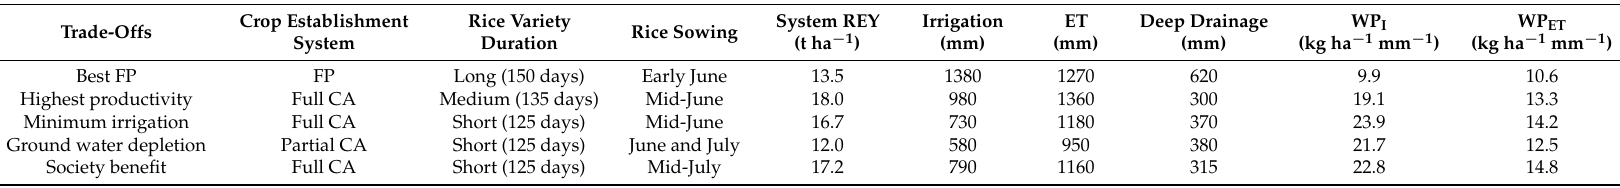
Table 3. Trade-off analysis between different system components under different objectives for various crop establishment methods, rice sowing dates, and variety duration [265,266]. FP—Farmer’s practice, CA—Conservation Agriculture, REY—Rice equivalent yield, ET—Evapotranspiration, WP ET —Water productivity based on evapotranspiration, WP I —Water productivity based on